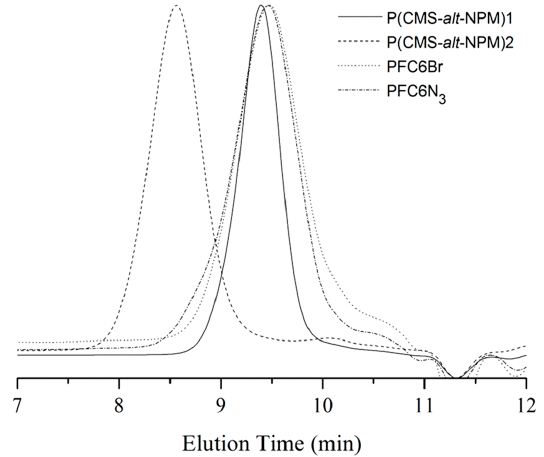
Figure 1. Gel permeation chromatography (GPC) curves of P(CMS- alt -NPM)1, P(CMS- alt -NPM)2, poly[(9,9-dihexylfluorene)-alt-(9,9-bis(6-bromohexyl)fluorene)] (PFC6Br) and PFC6N 3 .